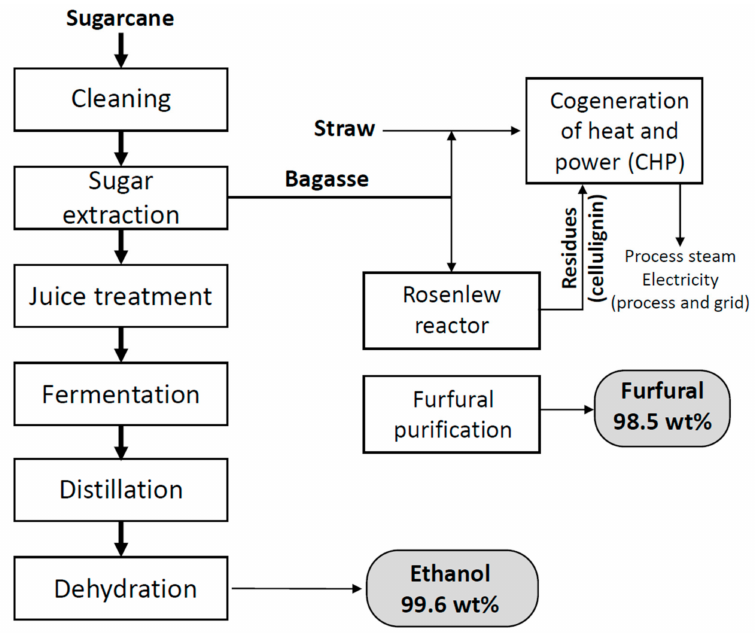
Figure 1. Block diagram of a bio-refinery producing ethanol, furfural, and electricity